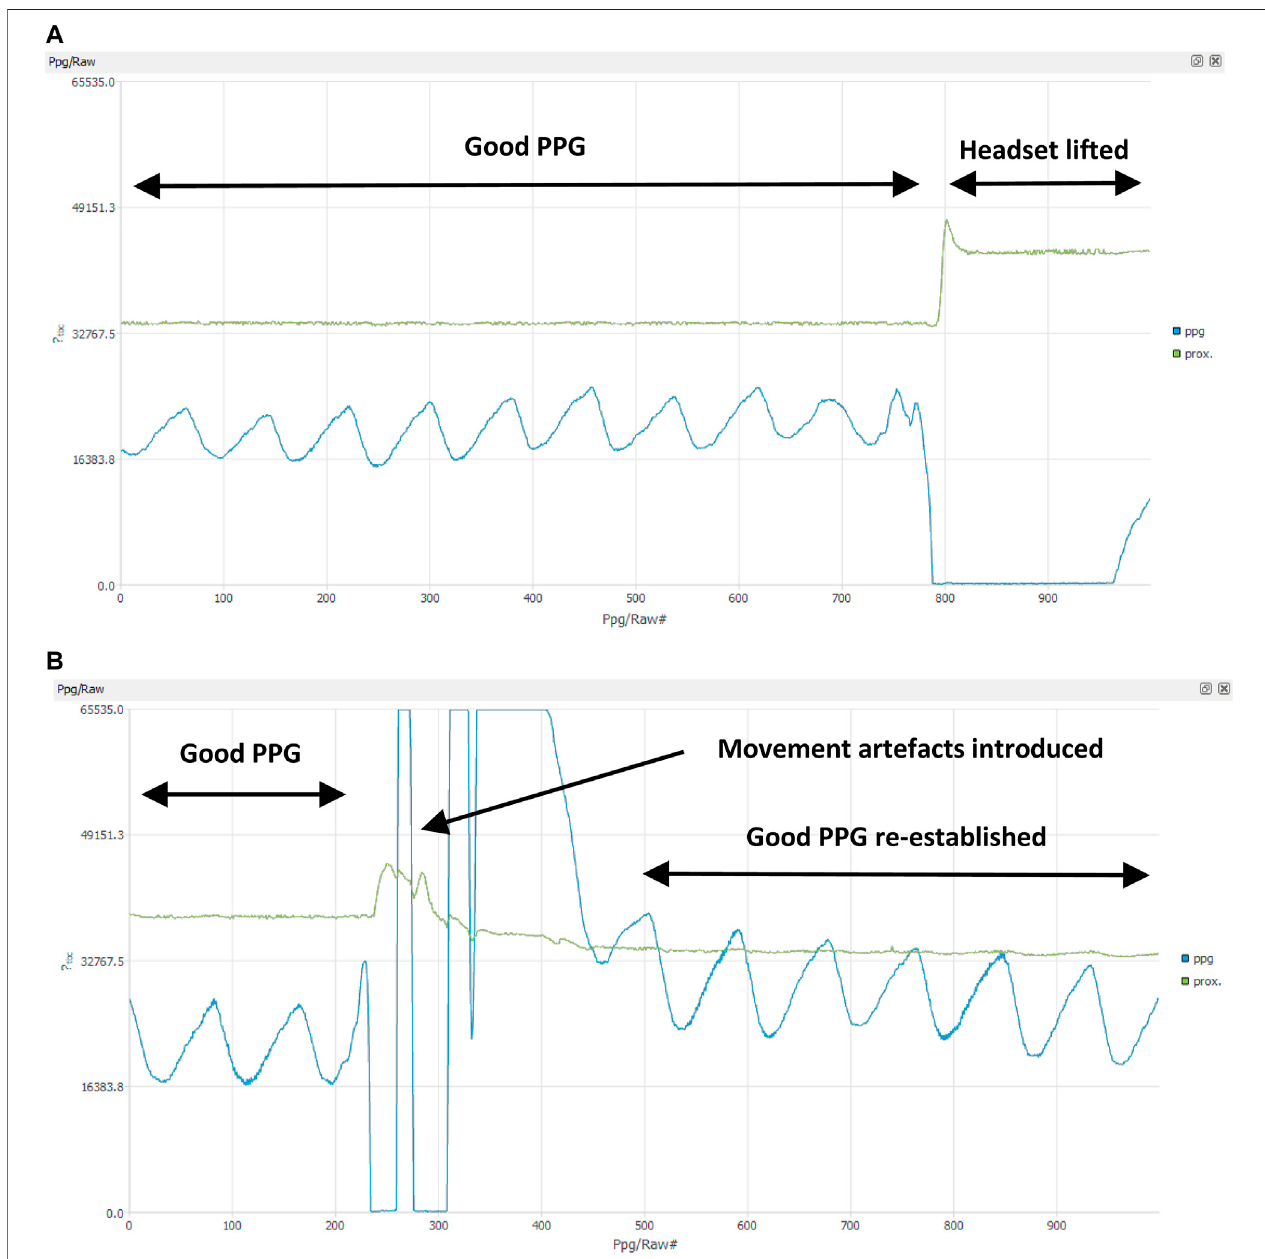
FIGURE 6 | Demonstration of how PPG proximity sensor can be used for identifying noise in PPG signal (A) EmteqPro was placed on the face and subsequently taken off. We can see changes in the light reaching the sensor and the loss of the PPG raw signal (B) EmteqPro was placed on the face and subsequently moved to create movement artefacts. Reduction in PPG signal quality can be observed when during fl uctuations recorded by the proximity sensor.